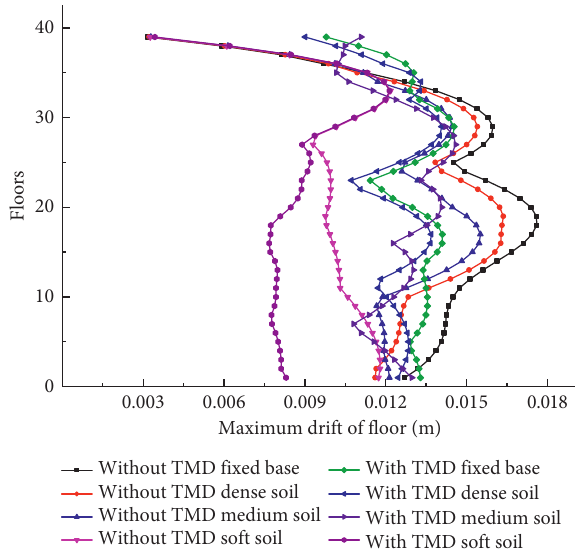
Figure 11: EL Centro earthquake maximum drift of floor comparison